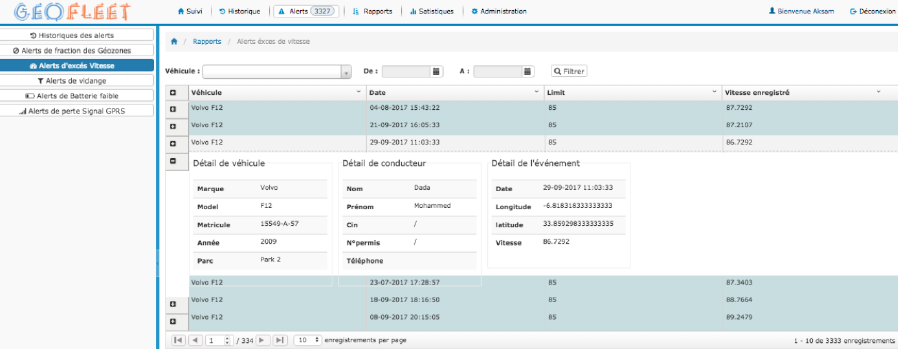
Figure 11. Screenshot of the server console depicting the speeding alert reporting information details.